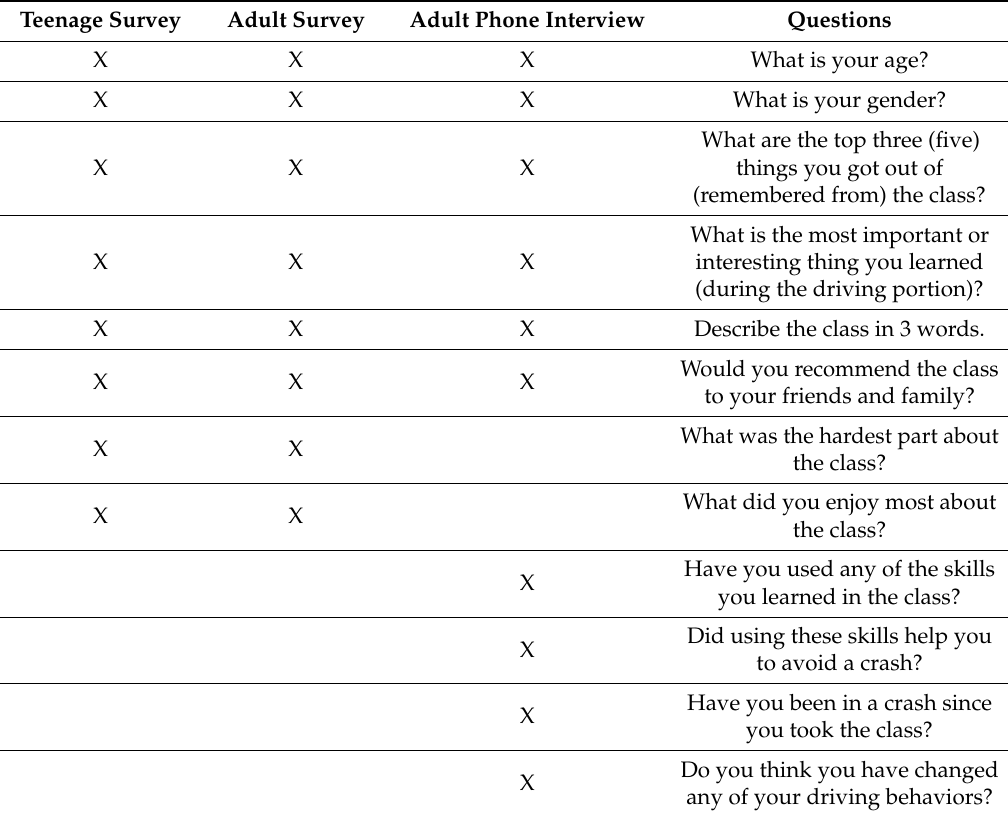
Table 2. Survey and follow-up phone interview questions. The words in parentheses were used for the follow-up phone